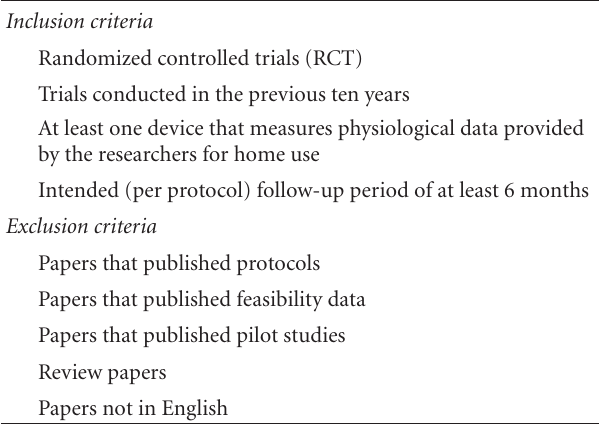
Table 1: Inclusion and exclusion